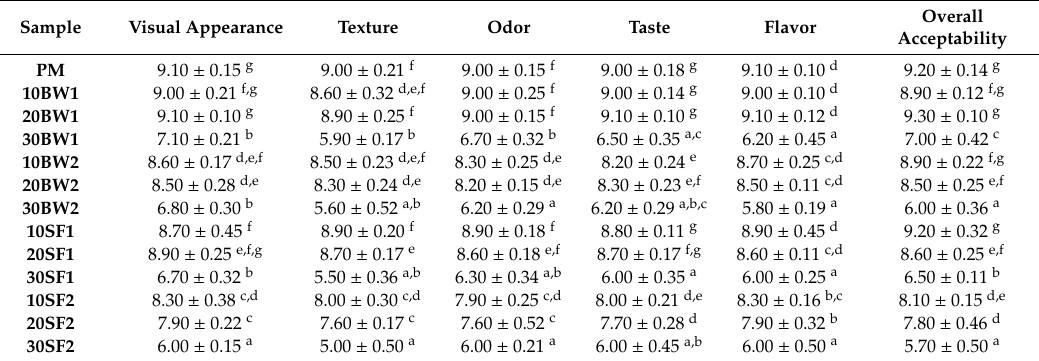
Table 10. Hedonic scores for